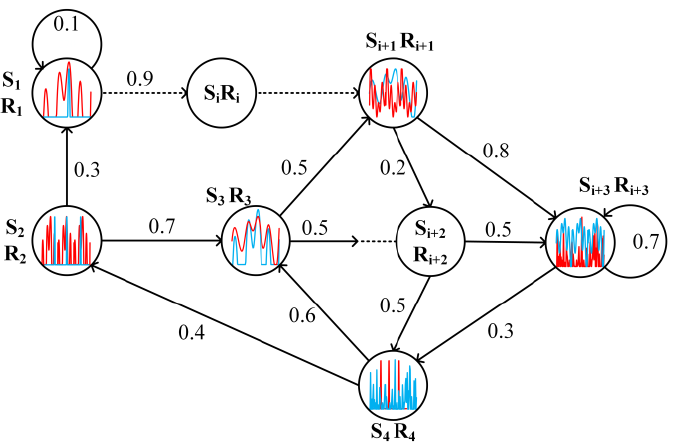
Figure 5. The radar countermeasure process based on markov decision process (MDP). The radar signal s ( t ) and the jamming signal j ( t ) are equally divided into M sub-bands in the frequency domain, and the sub-band power is equally divided into N